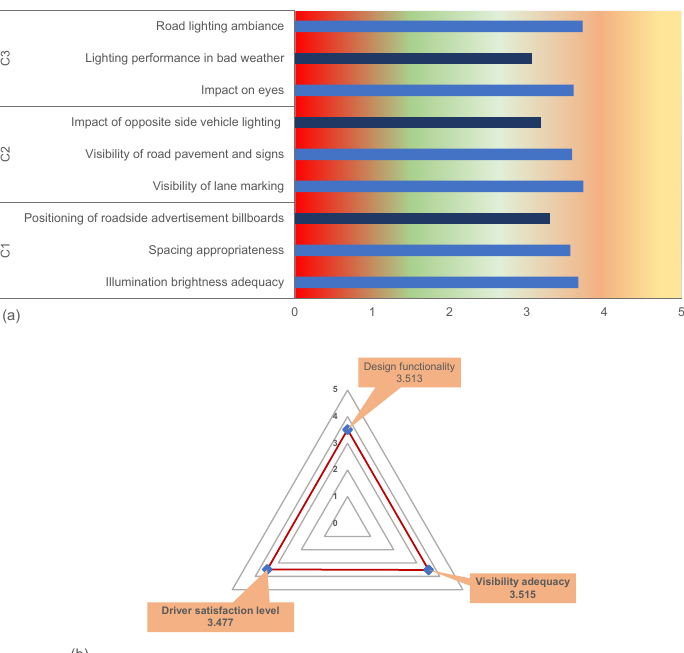
Figure 6. Fuzzy synthetic evaluation (FSE) results: ( a ) sub-criteria scores and ( b ) criteria scores.